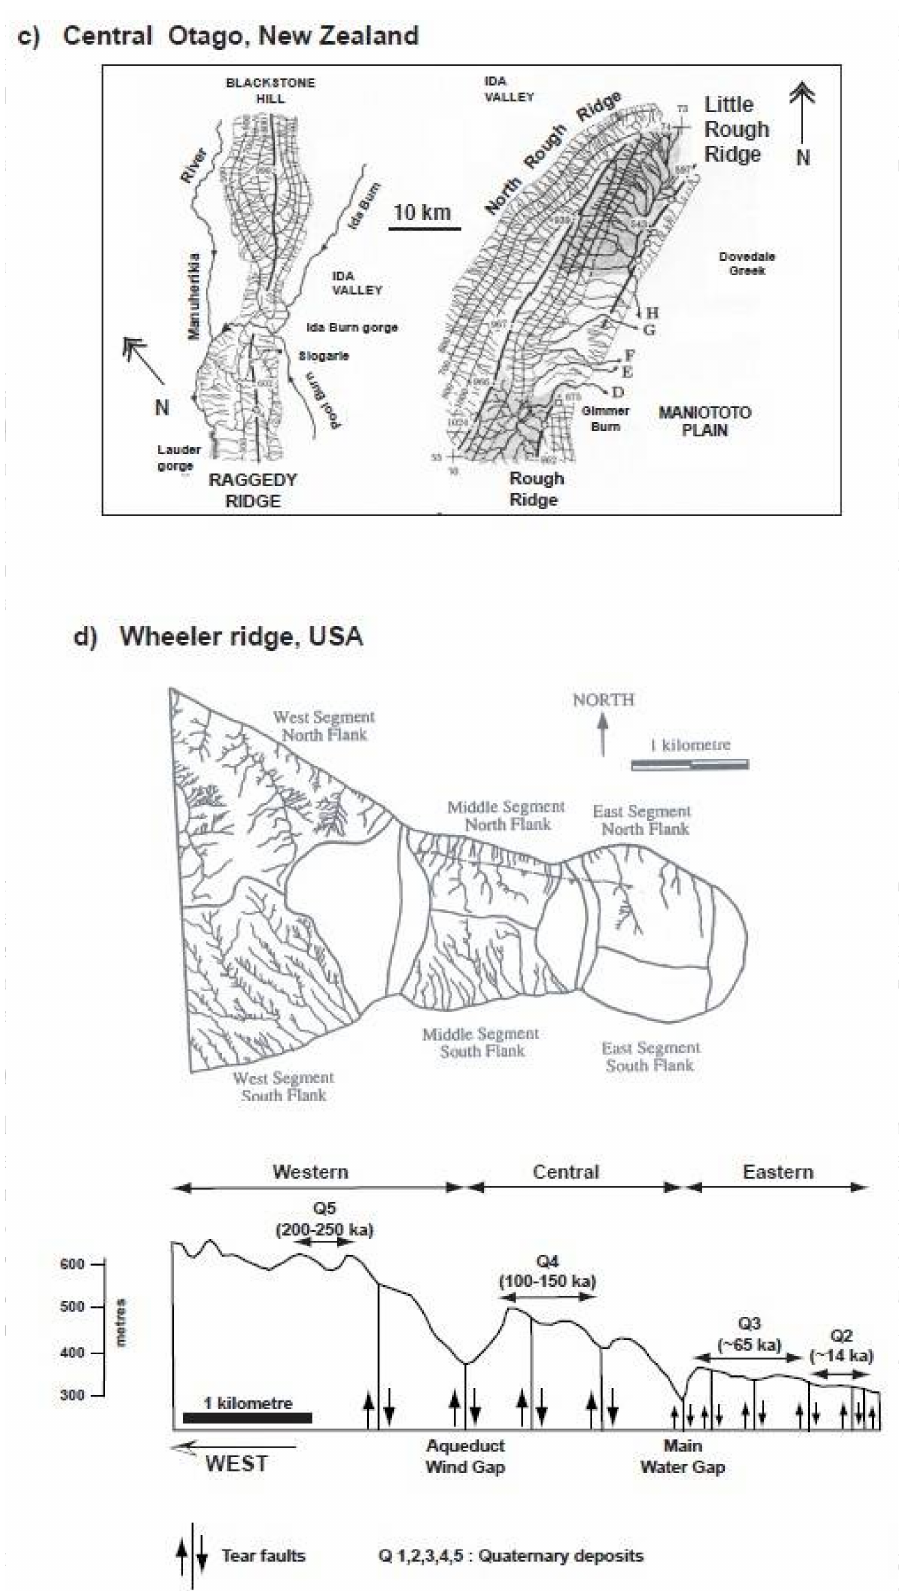
Figure 1. Cross-sections, drainage networks and axial surface maps developed above fault-related fold structures: ( a ) Pakuashan anticline, Taiwan (after Delcaillau et al. [10] and Delcaillau [67]), ( b ) the Tunic anticline (modified from Shaw et al. [68]), ( c ) Folds from central Otago, New Zealand (after Jackson et al. [8]), ( d ) Wheeler Ridge anticline, California (after Mueller and Talling [9], Talling and Sowter